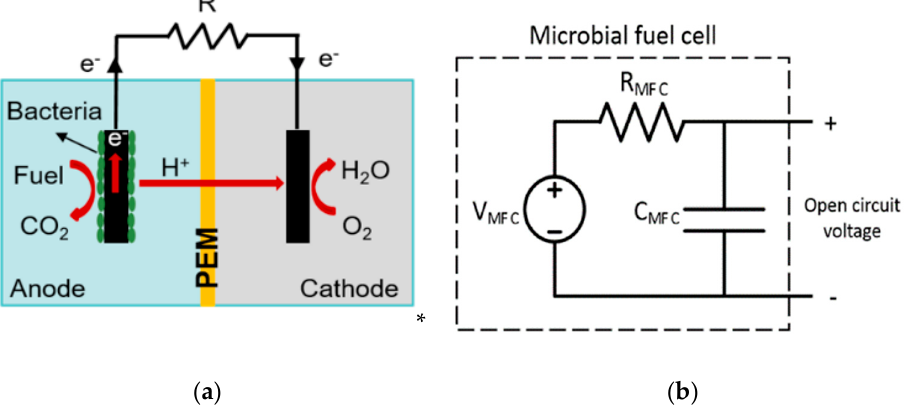
Figure 1. Microbial Fuel Cell (MFC) device description ( a ) schematic and ( b ) electrical model.